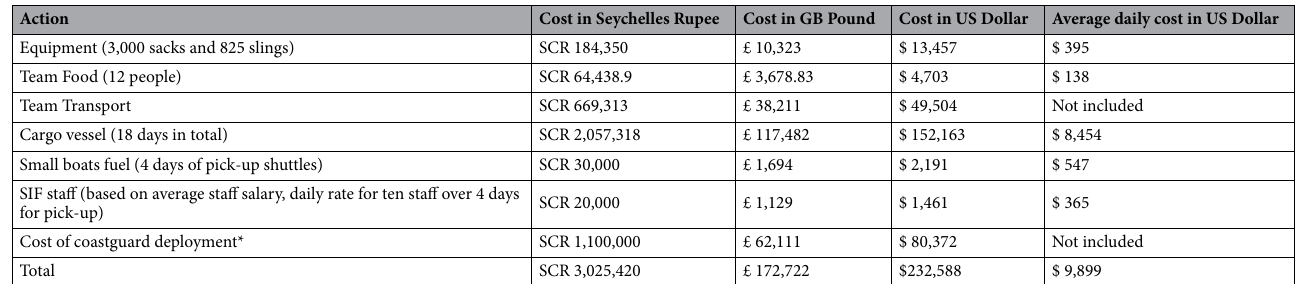
Table 1. Summary of the costs involved in the 34-day clean-up. *This was not covered by project costs but by the Seychelles Government. The coastguard deployment would not necessarily be essential in future operations, if sufficient additional staff were present, therefore the cost has not been included